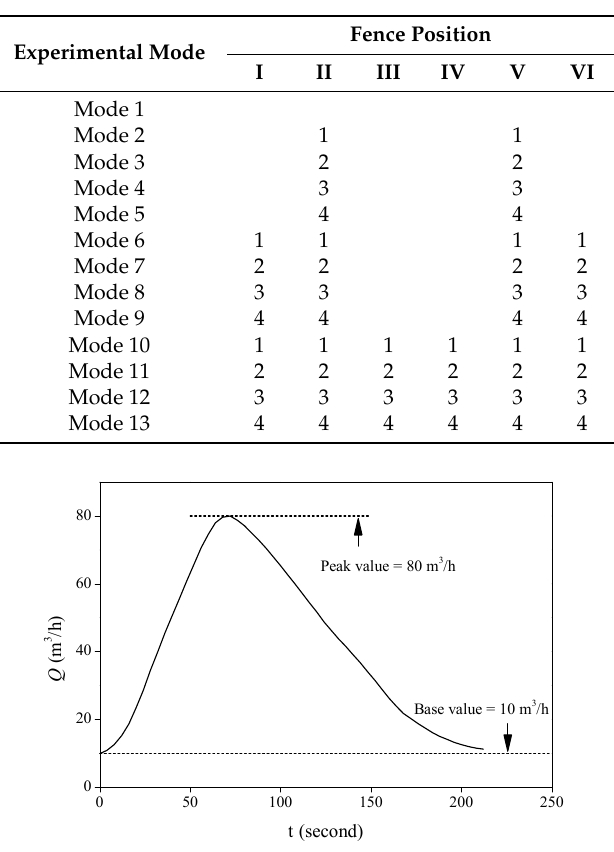
Table 1. Details of 13 different modes of river-bed conditions.